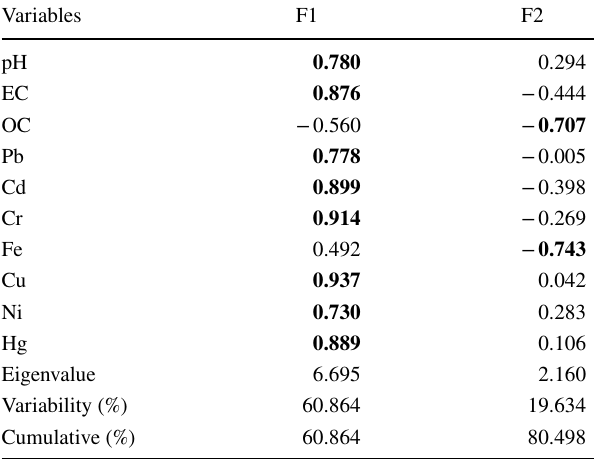
Table 12 Factor loading matrix (after varimax rotation), eigenvalues and variances for sediment samples